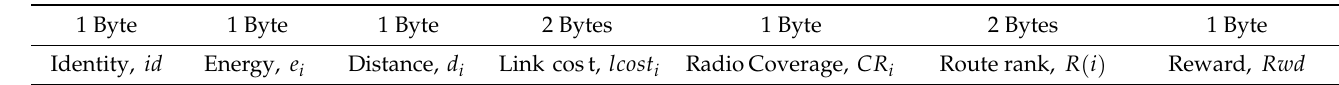
Table 2. Node level